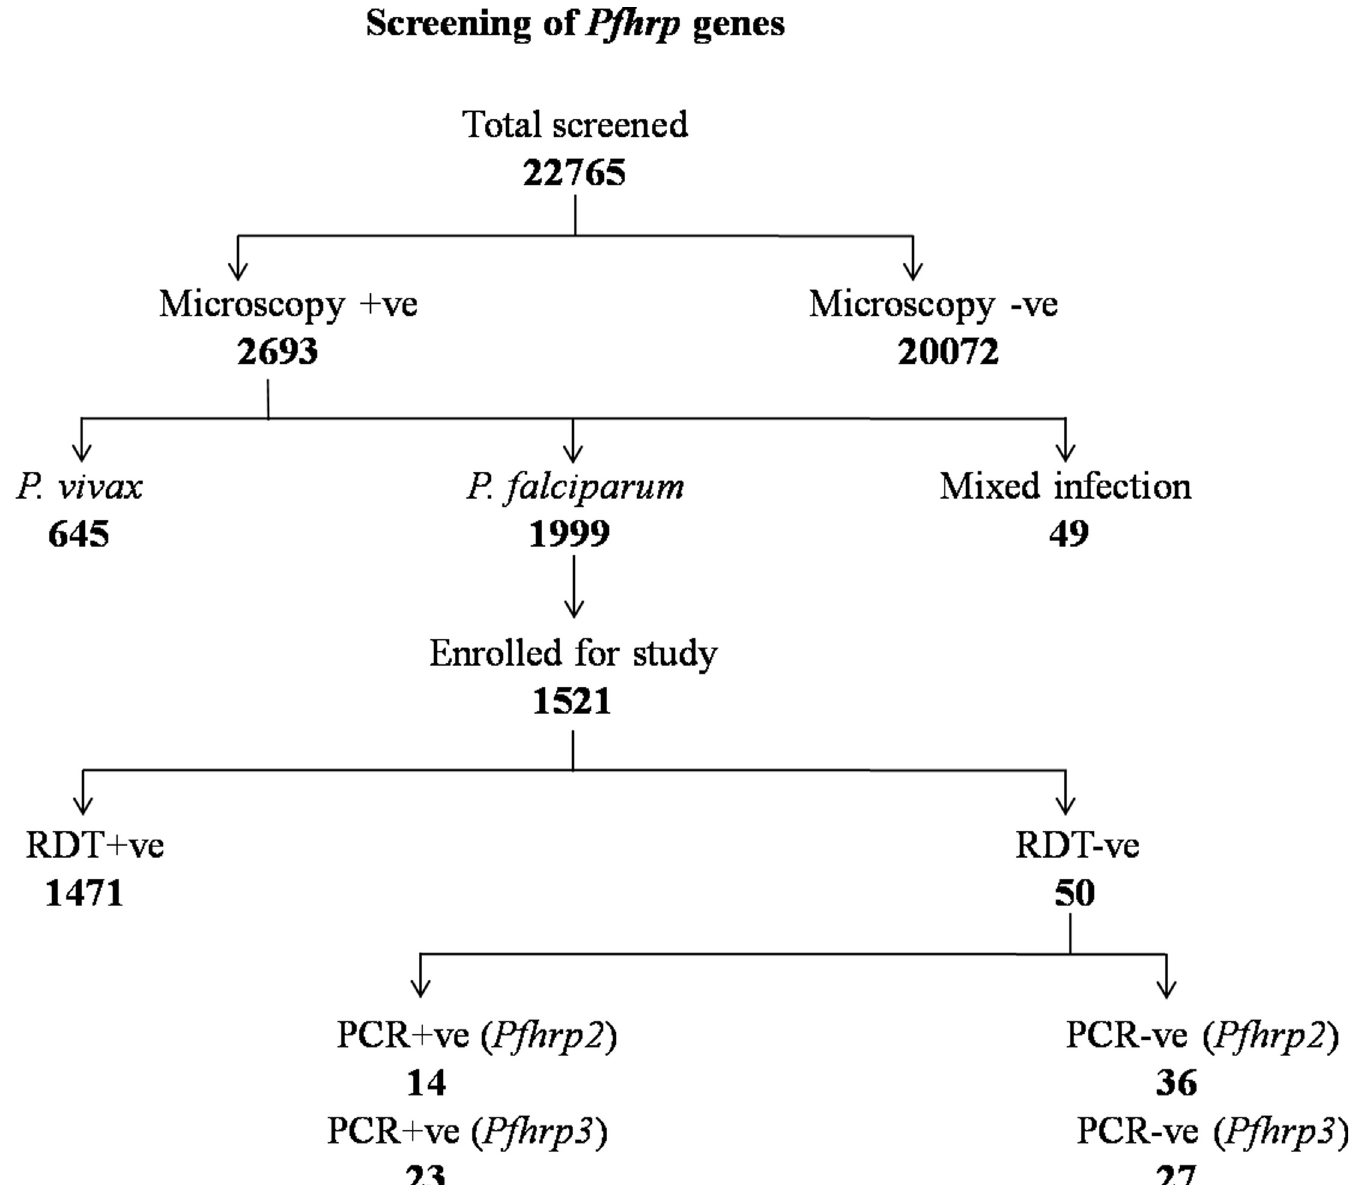
Fig 2. Flow chart showing Screening of malaria cases by microscopy, RDT and polymerase chain reaction (PCR) for pfhrp2 and pfhrp3 gene.